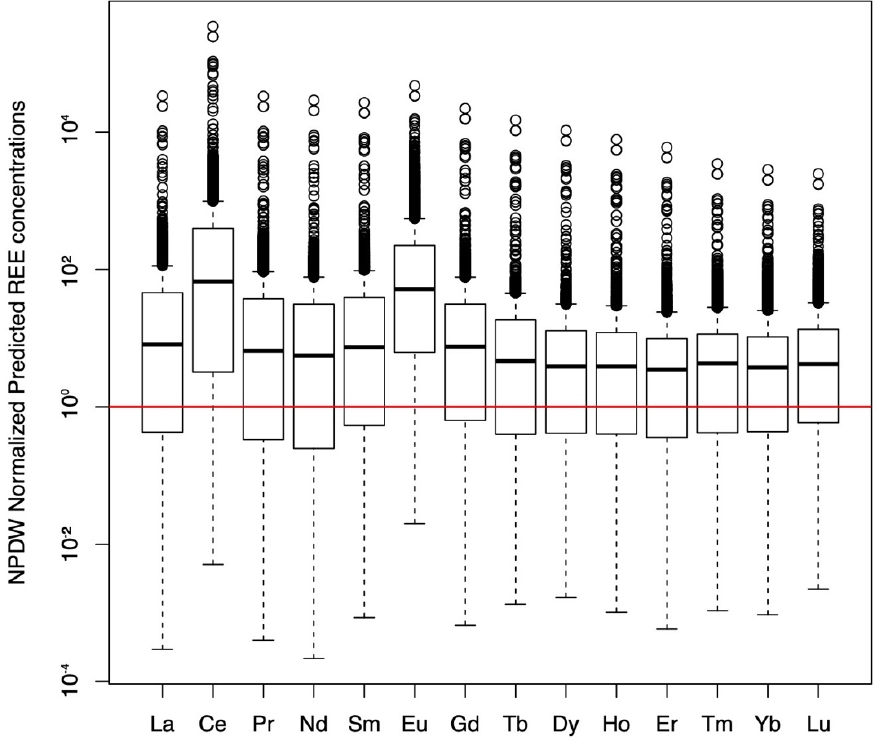
Figure 6. Predicted REE concentrations in produced and geothermal waters from the abridged USGS database relative to seawater (NPDW normalization). Thick red line denotes median and whiskers are drawn out to 1.5 times the interquartile range beyond the 3rd and 1st quartiles. Circles indicate values beyond the whiskers.